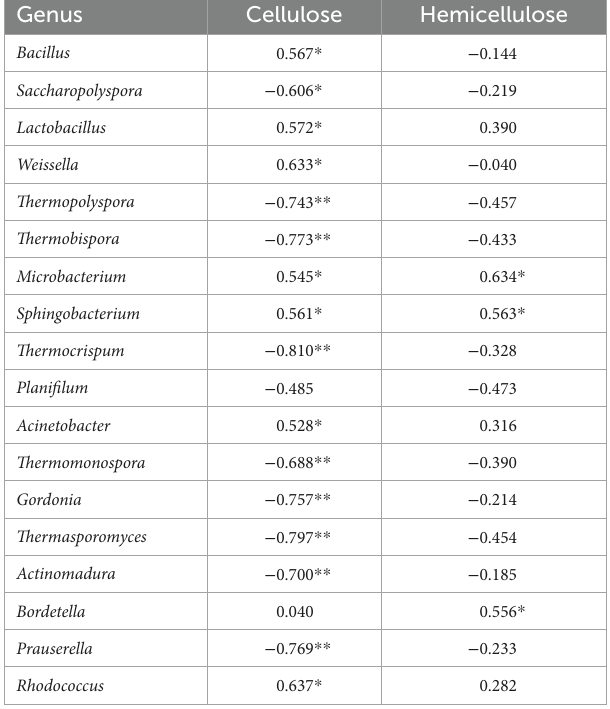
TABLE 1 Pearson’s correlation analysis between the concentration of cellulose or hemicellulose and the relative abundance of bacteria at the genus